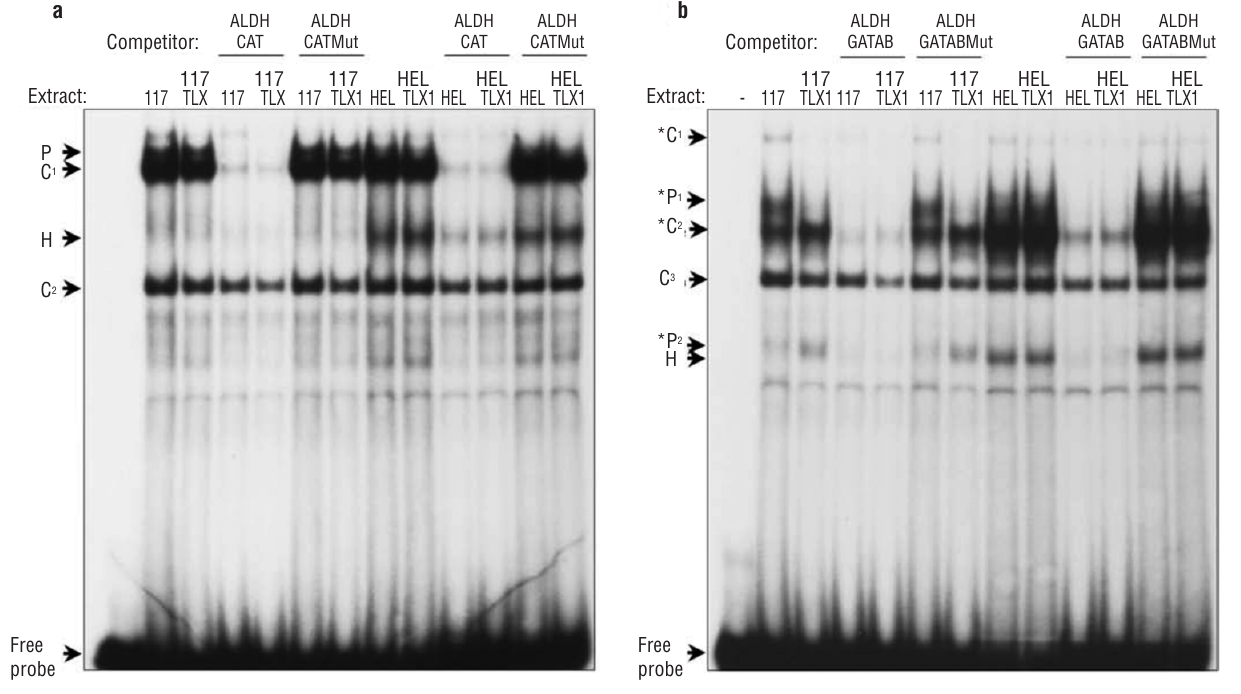
Figure 4. Effect of TLX1 on ALDH1A1 promoter DNA-binding complexes. (A) TLX1 does not affect DNA-protein complex formation at the -74 CCAAT box. EMSA using a 32 P-labeled double-stranded oligonucleotide containing the CCAAT site at -74 of the human ALDH1A1 promoter (ALDH CAT). The assay was performed with nuclear extracts prepared from PER-117 (left lanes) or HEL cells (right lanes) with and without overexpression of TLX1. The migration of the free probe is indicated along with the positions of specif- ic DNA-protein complexes (C1 and P in PER¬117 cells; C1 and H in HEL cells). Overbars denote the addition of a 35-fold molar excess of unlabeled double-stranded self (ALDH CAT) or mutant (ALDH CATMut) probe as competitor. (B) TLX1 alters DNA-pro- tein complex formation at the -33 GATA box. EMSA performed as above using a labeled oligonucleotide containing the GATAAA site at -33 of the human ALDH1A1 promoter (ALDH GATAB). The migration of the free probe is indicated along with the positions of specific DNA-protein complexes (C1, C2, P1 and P2 in PER-117 cells; C1, C2 and H in HEL cells). Overbars denote the addition of a 35-fold molar excess of unlabeled double-stranded self (ALDH GATAB) or mutant (ALDH GATABMut) probe as competitor. Asterisks denote complexes altered by